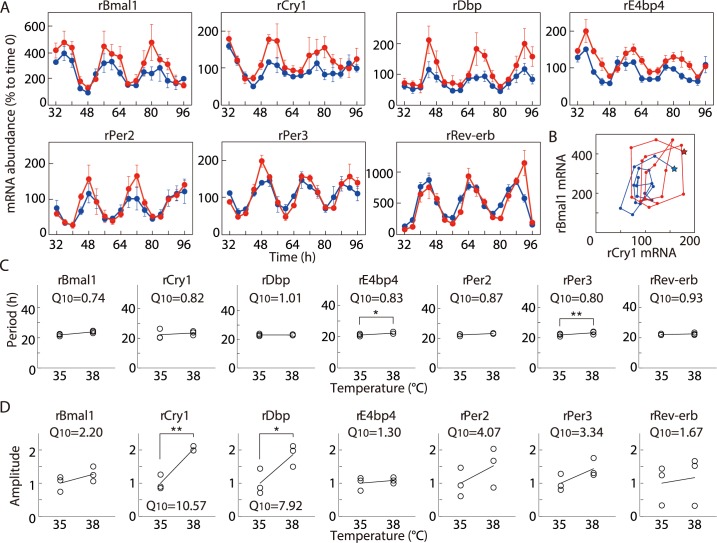
Temperature-dependent variation of circadian clock gene expression.(A) Representative time course of clock gene mRNA expression in C6 glioma cells at 35°C and 38°C. Results are expressed relative to time 0 (%) for clock mRNAs rBmal1, rCry1, rDbp, rE4bp4, rPer2, rPer3, and rRev-erbα. The values are means (±SEM) of at least three independent experiments. Blue circles/lines depict values obtained at 35°C and red circles those acquired at 38°C. (B) Oscillatory trajectory at 35°C (blue) and 38°C (red) plotted on a plane with x- and y-axes showing the amounts of rCry1 and rBmal1 mRNA, respectively. Stars represent the starting points of the trajectories. (C) Periods and Q10 values of the circadian rhythm at 35°C and 38°C. All data were obtained from three independent experiments (*p < 0.05 and **p < 0.01 by Student’s t-test). Solid lines represent regression lines. (D) Amplitudes and Q10 values of the circadian rhythm at 35°C and 38°C. Values on the y-axis are fold changes over mean amplitudes for each gene at 35°C. The data were obtained from three independent experiments (*p < 0.05 and **p < 0.01 by Student’s t-test). Solid lines represent regression lines.